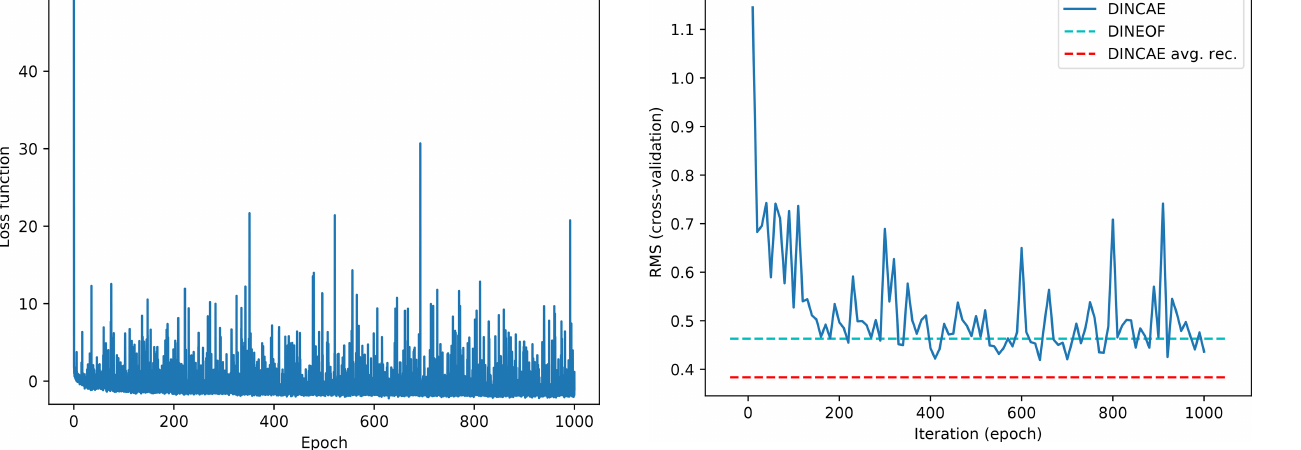
Figure 2. The cost function computed internally for every mini- batch during the optimization.